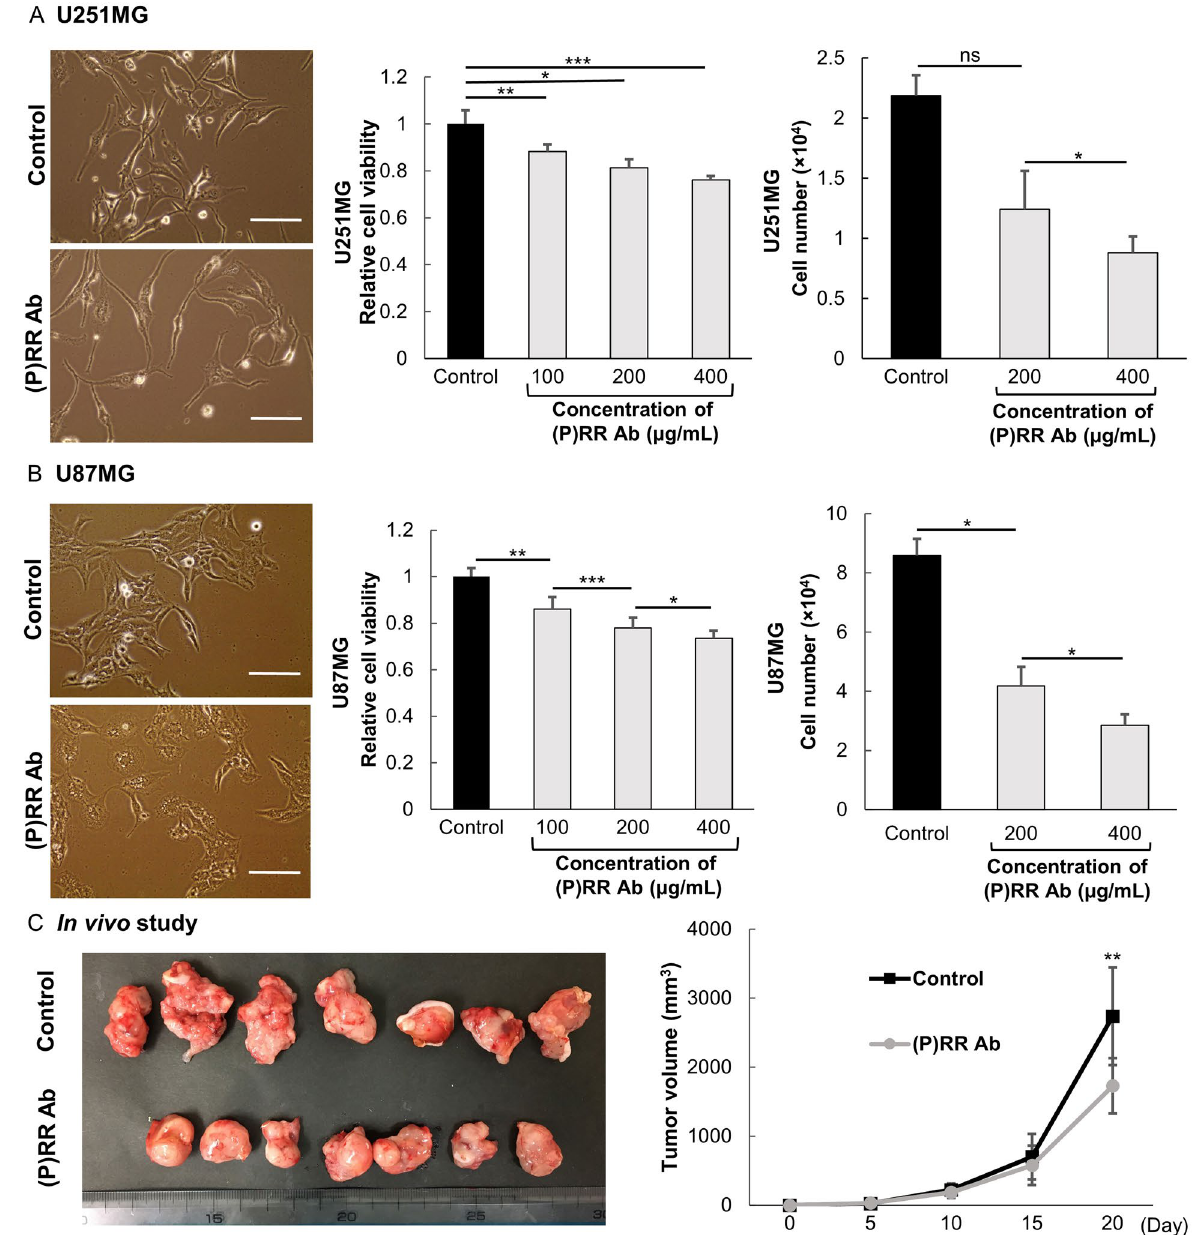
Figure 3. Antiproliferative effects of the (P)RR Ab on human glioblastoma cell lines in vitro and in vivo. The (P)RR Ab dose-dependently reduced cell proliferation in WST-1 ( n = 3) and cell numbers ( n = 4) in ( A ) U251MG cells and ( B ) U87MG cells (scale bar = 200 µm). ( C ) In vivo antitumor effect of systemic administration of the (P)RR Ab on engrafted tumors of U87MG cells in athymic nude mice 20 days after injection (left), and time dependent changes in tumor volume (right). The mean tumor volume after 20 days was 1730 ± 399 mL vs. 2739 ± 707 mL ( P < 0.01, n = 7). * P < 0.05; ** P < 0.01; *** P <